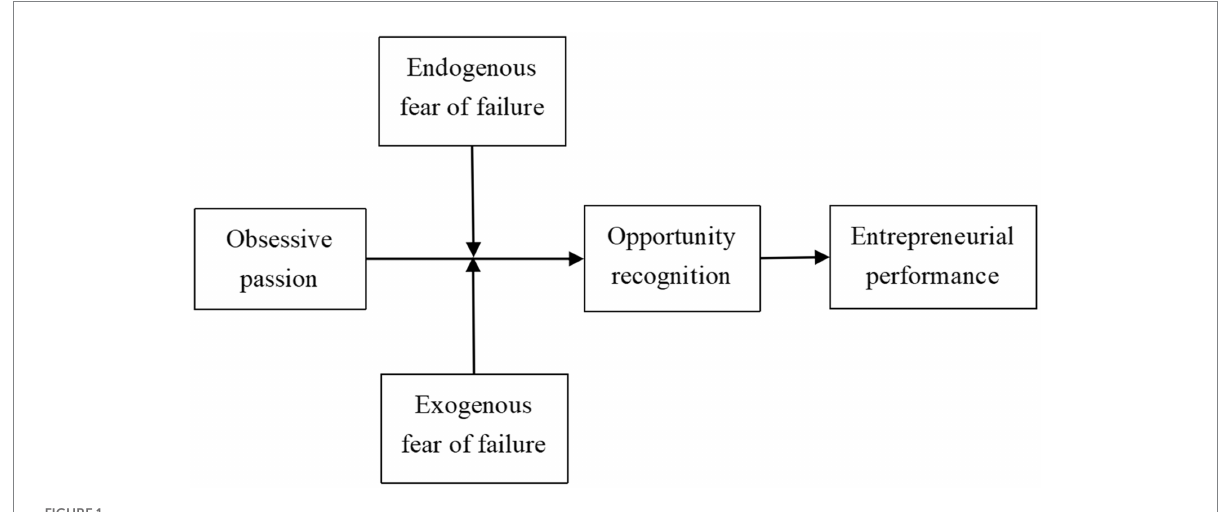
FIGURE 1 Research